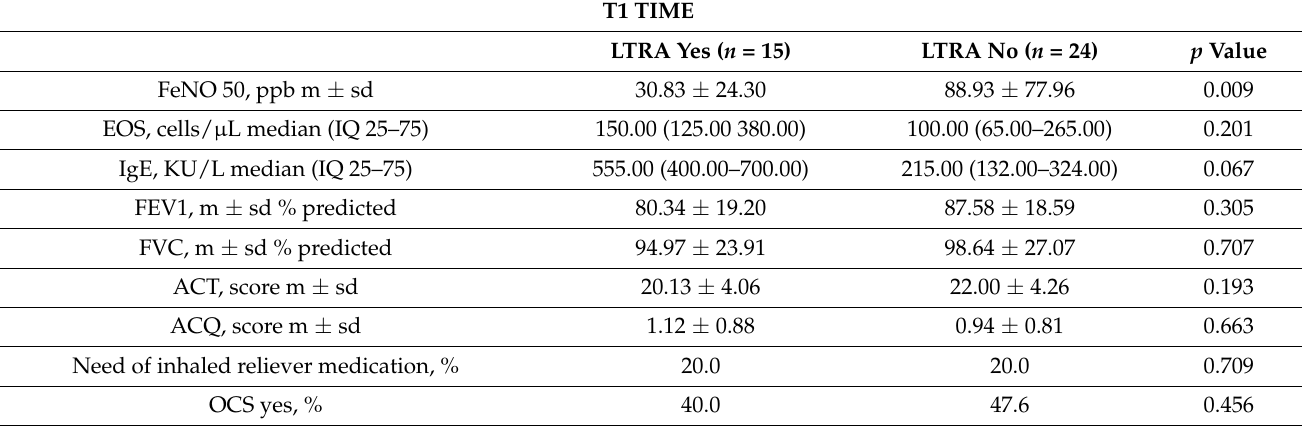
Table 3. Comparison based on taking LTRA therapy 6 months after starting biological